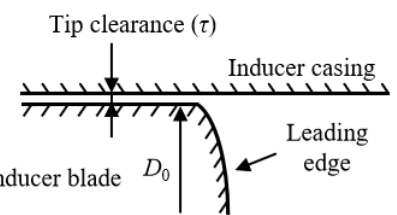
Figure 1. Schematic of the three-bladed model inducer in ( a ) front view and ( b ) side view.